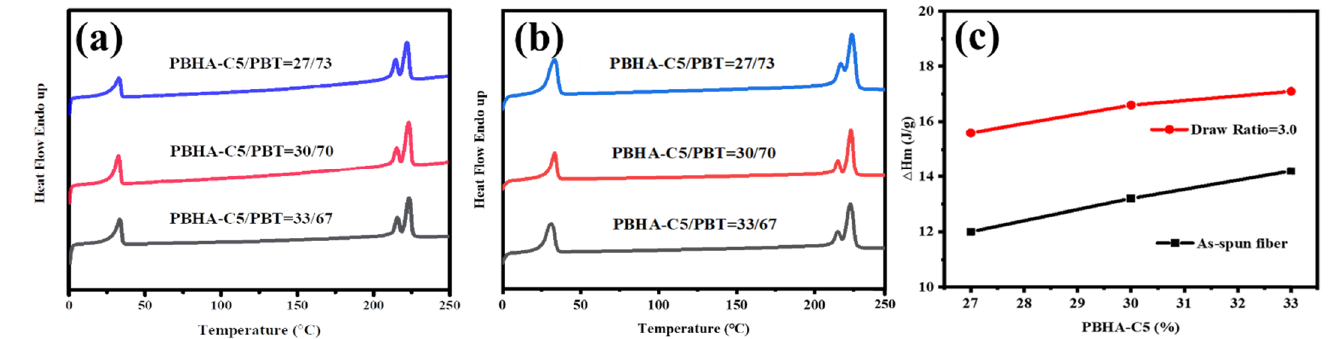
Figure 11. DSC curves of fiber samples in the first heating trace: ( a ) as-spun fiber, ( b ) fiber at draw ratio = 3.0, and ( c ) plots of melting enthalpy for the as-spun fiber and with draw ratio of 3.0 as a function of PBHA-C5 content.